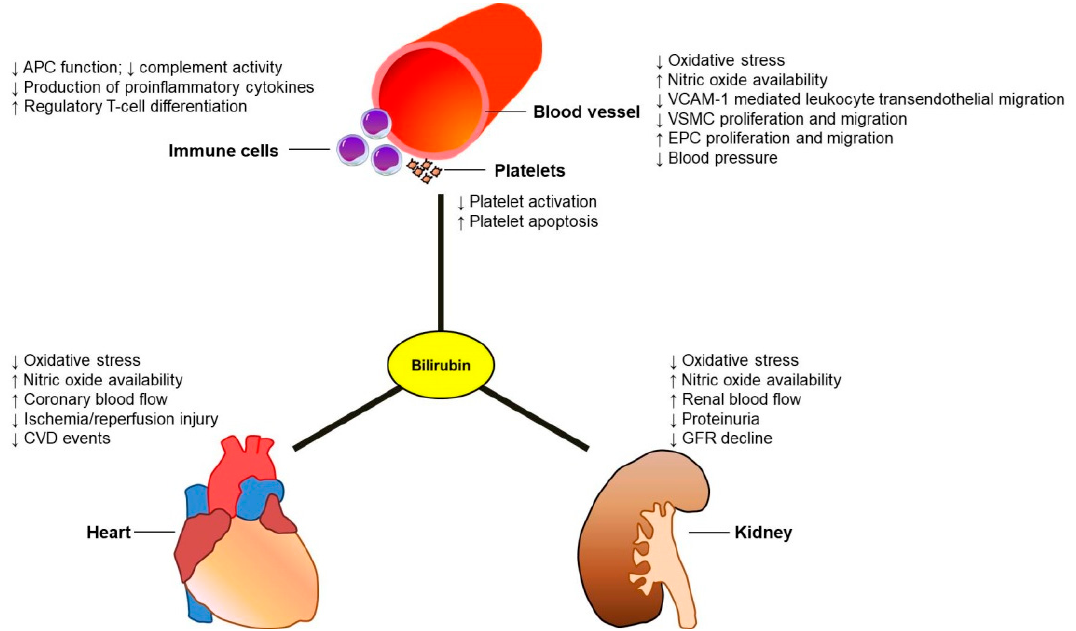
Figure 2. Cardiovascular and renal effects of bilirubin. In blood vessels, bilirubin can reduce oxidative stress and increase nitric oxide levels to maintain cardiovascular homeostasis. Bilirubin can also decrease the size of atherosclerotic plaques following vascular endothelial injury, through the suppression of VSMC proliferation and migration as well as improved EPC function. In addition, there is accumulating evidence that bilirubin has an antithrombotic effect by inhibiting platelet aggregation and promoting its apoptosis. Finally, bilirubin may exert its immunomodulatory effects by interacting with both the innate and adaptive responses. These findings support a potential role for bilirubin in protecting from the development and progression of both chronic kidney disease and cardiovascular disease. Abbreviations: APC, antigen-presenting cells; CVD, cardiovascular disease; EPC, endothelial progenitor cells; GFR, glomerular filtration rate; VCAM-1, vascular cell adhesion molecule 1; VSMC, vascular smooth muscle cells.